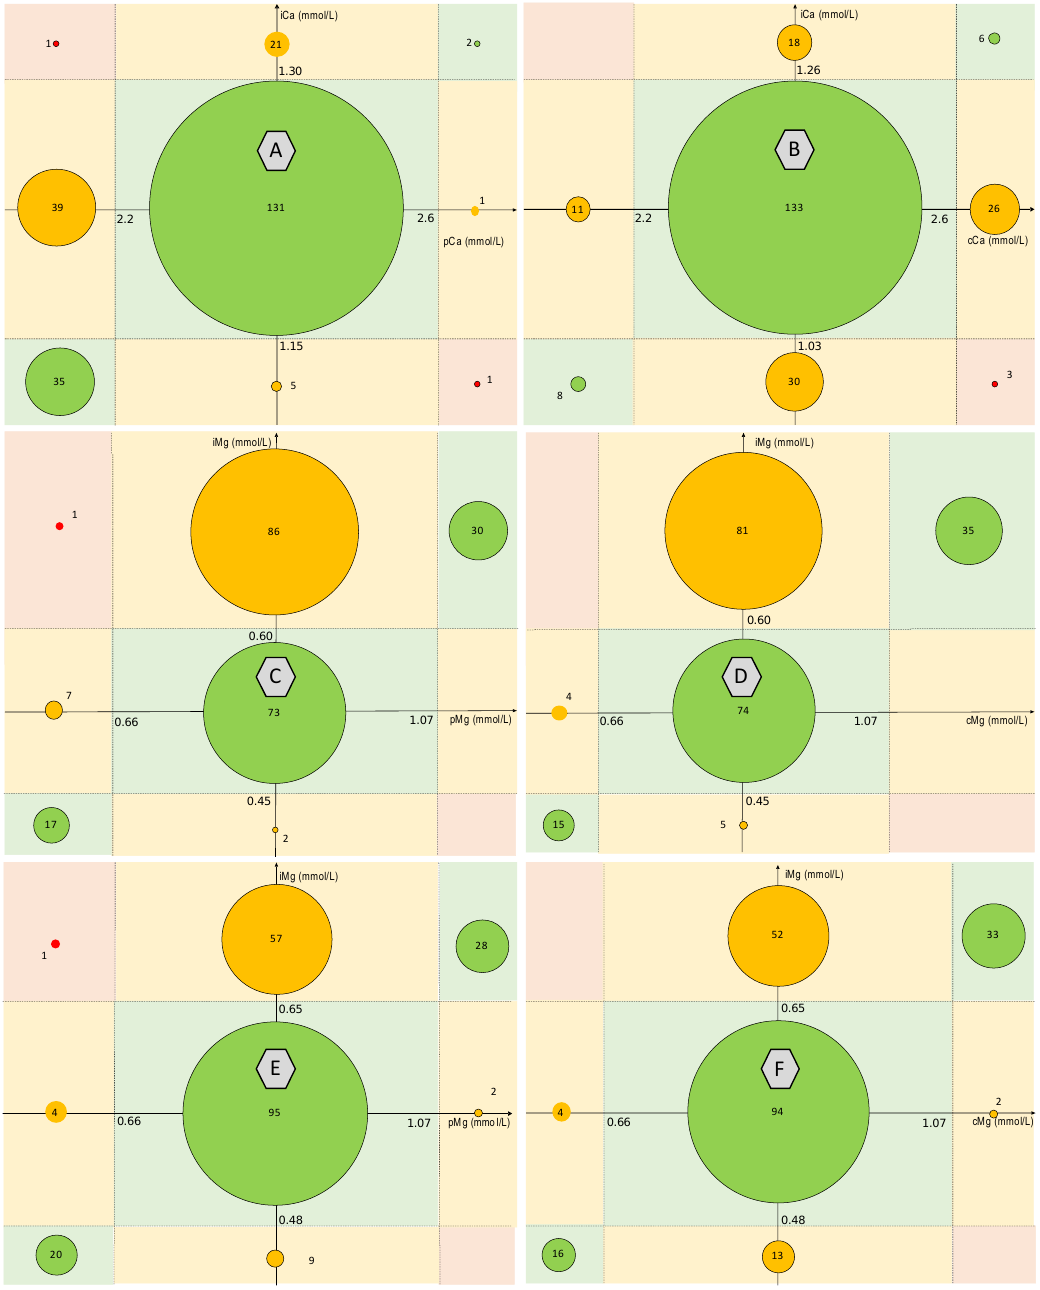
Figure 1. Agreement between the biological interpretation of ionized and total Mg and Ca forms according to the reference values used. A: agreement between iCa and pCa; B: agreement between iCa and cCa; C: agreement between iMg and pMg according to the manufacturer’s range; D: agreement between iMg and cMg using the manufacturer’s range; E: agreement between iMg and pMg using the determined reference range; F: agreement between iMg and cMg using the determined reference range. Correction formulas used for cCa and cMg are: cCa = pCa + 0.025 (40-albumin) and cMg = pMg + 0.005 (40-albumin). ICa = ionized calcium, pCa = plasmatic calcium, cCa = albumin-corrected calcium. iMg = ionized magnesium, pMg = plasmatic magnesium, cMg = albumin-corrected